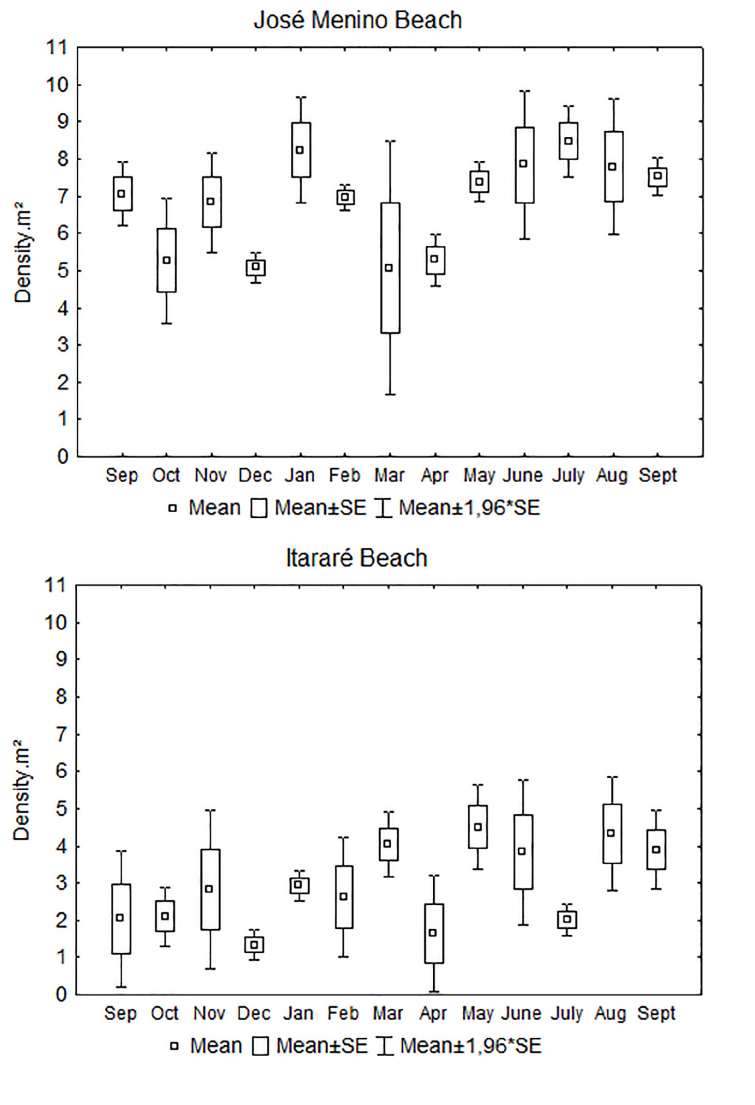
Figure 2. Densities of C. major at José Menino and Itararé monthly